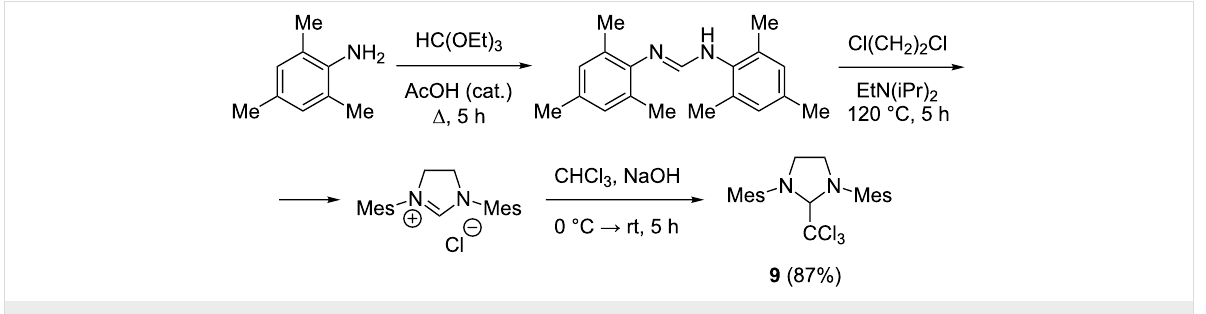
Scheme 5: Synthesis of the “chloroform adduct” 9